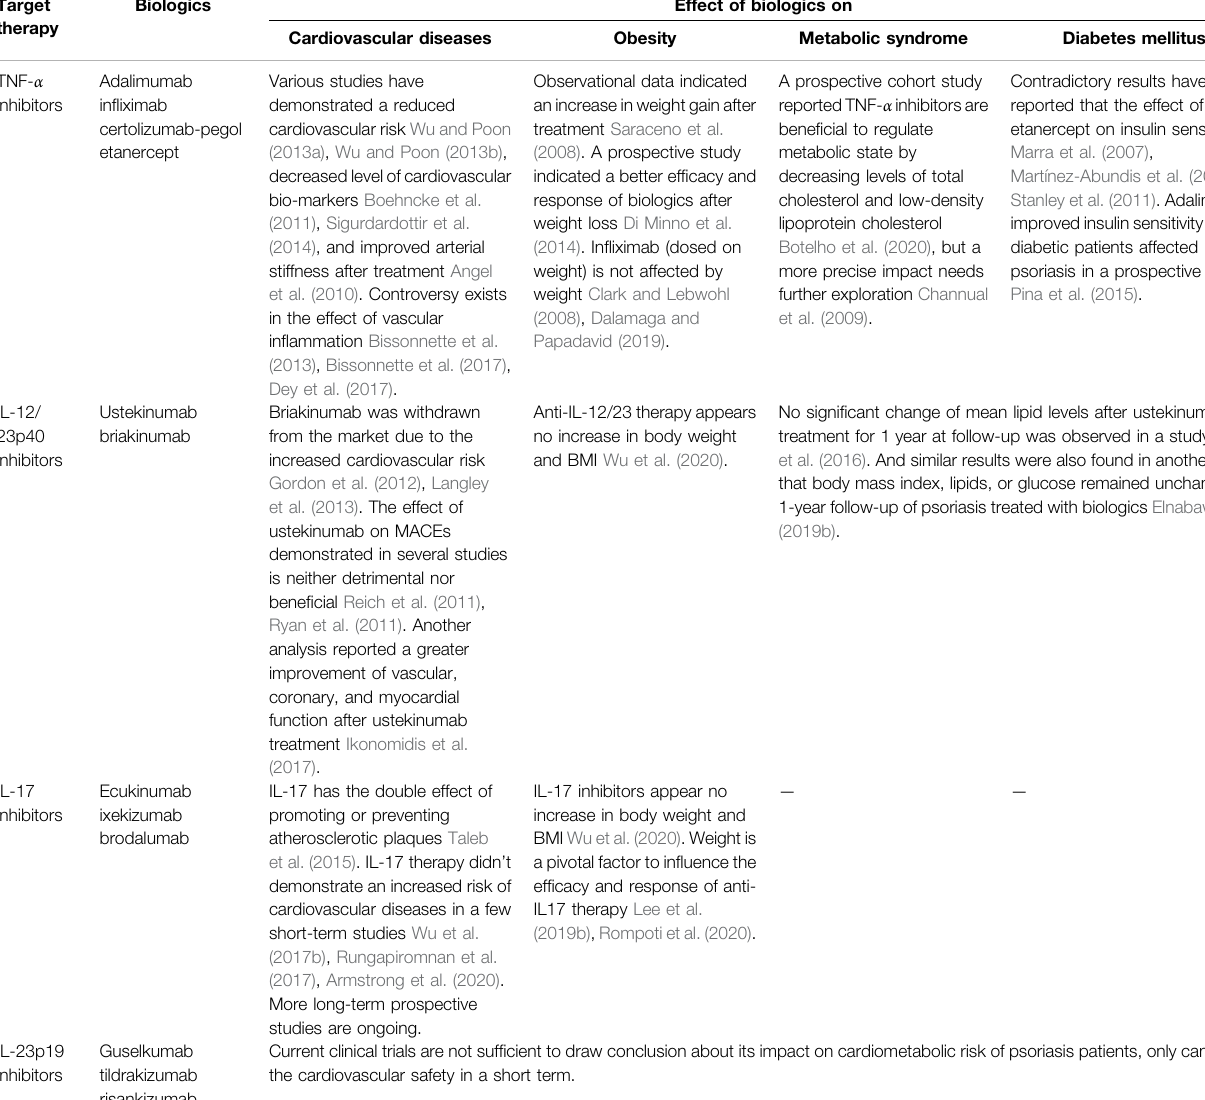
TABLE 1 | Effect of biologics on cardiometabolic